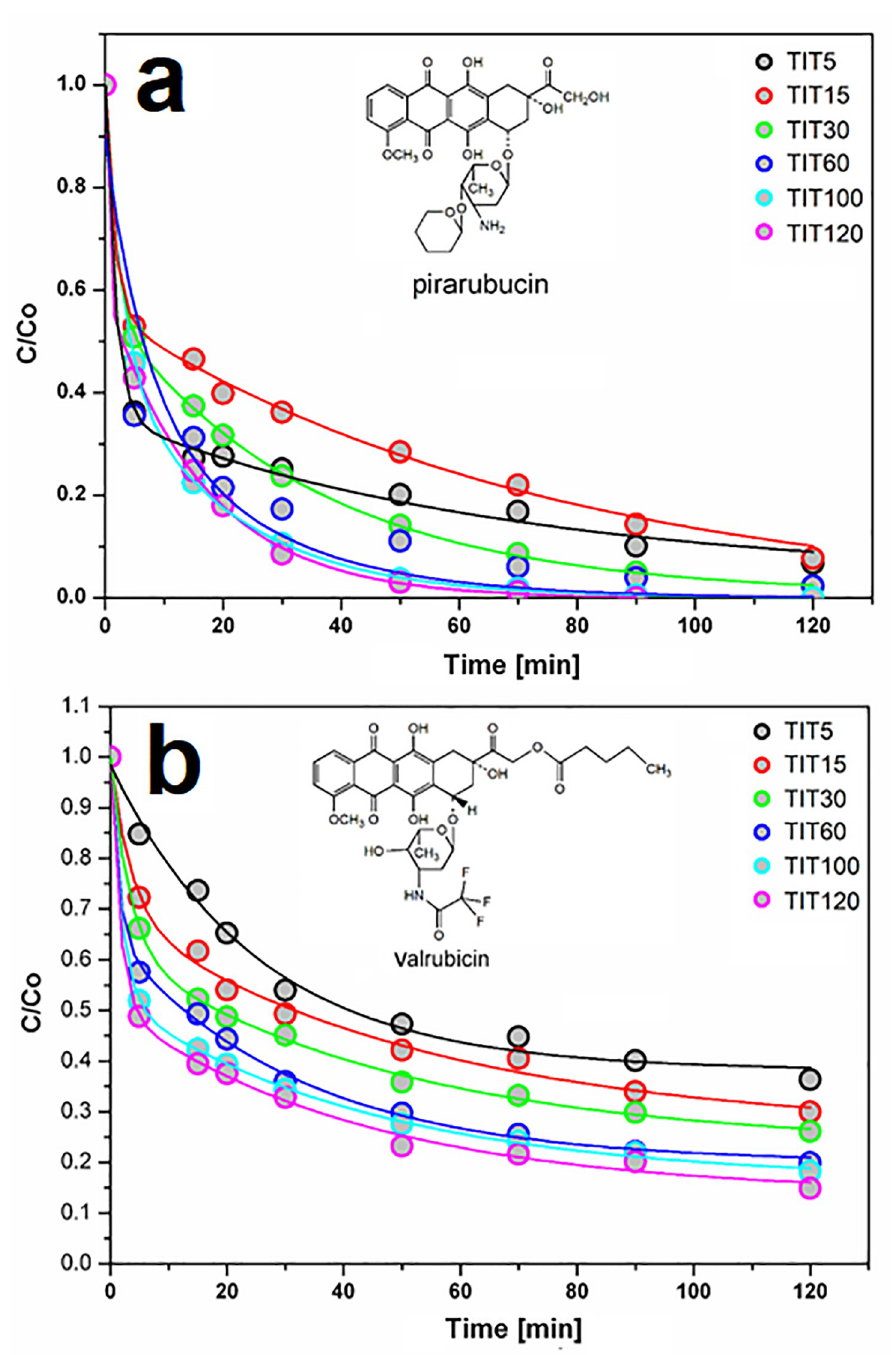
Fig 10. Normalized kinetic curves of pirarubicin (a) and valrubicin (b) adsorption on TiO 2 samples differing in